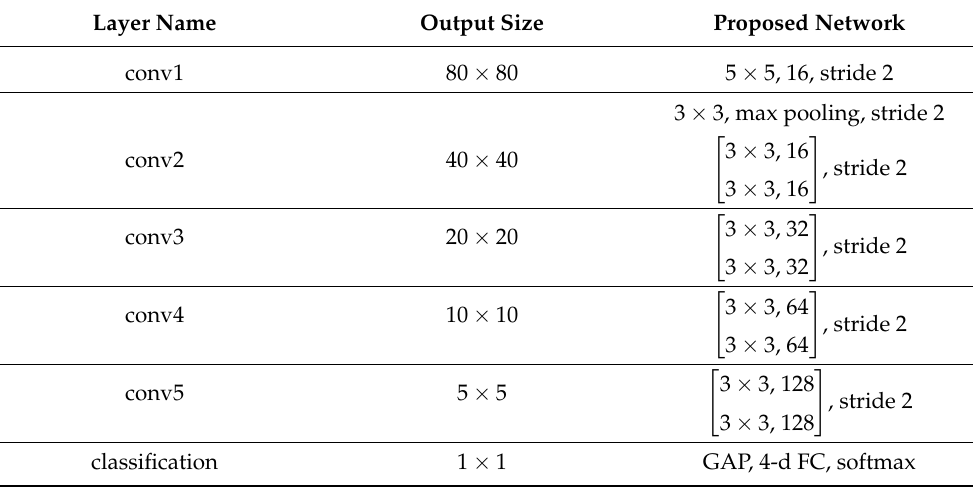
Table 1. Architecture of our proposed network. Blocks shown in brackets of the same convolutional layer are represented by the same color as in Figure 3. For instance, “3 × 3, 16” indicates 16 filters with a size of 3 × 3.